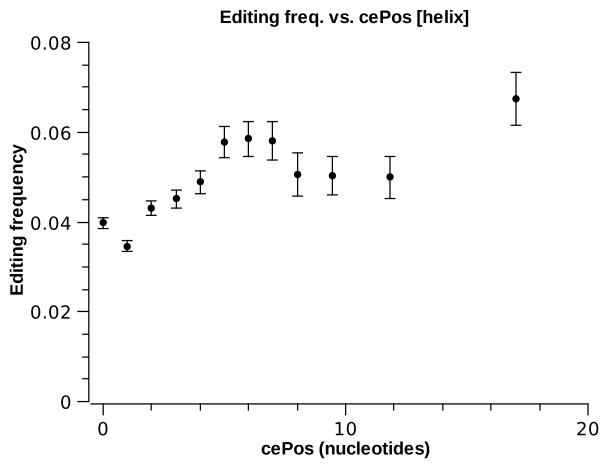
E1 frequency vs. cePos for helices.